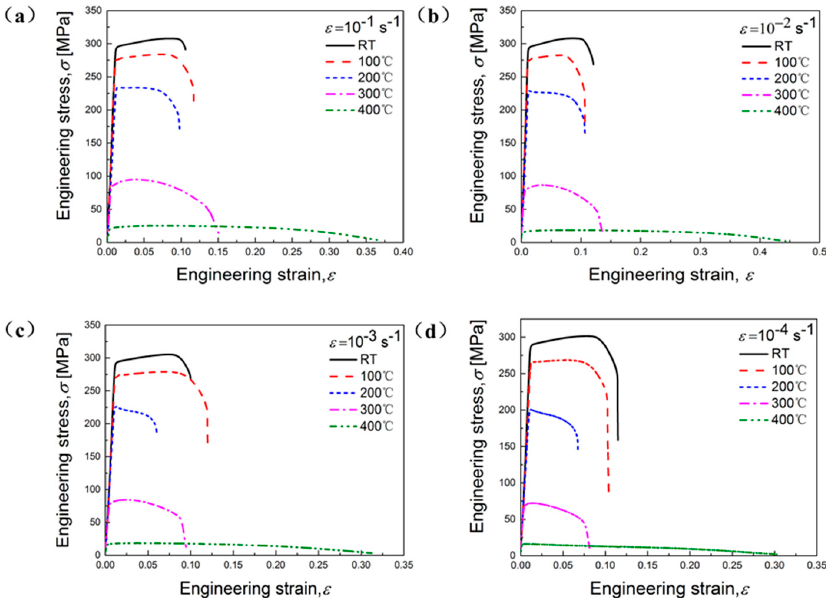
Figure 2. Engineering stress versus strain curves of the studied Al-Zn-Mg-Cu alloy for tension at various strain rates: ( a ) 10 − 1 s − 1 ; ( b ) 10 − 2 s − 1 ; ( c ) 10 − 3 s − 1 ; ( d ) 10 − 4 s − 1 .